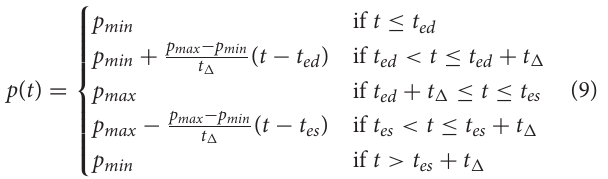
Frontiers in Cardiovascular Medicine |